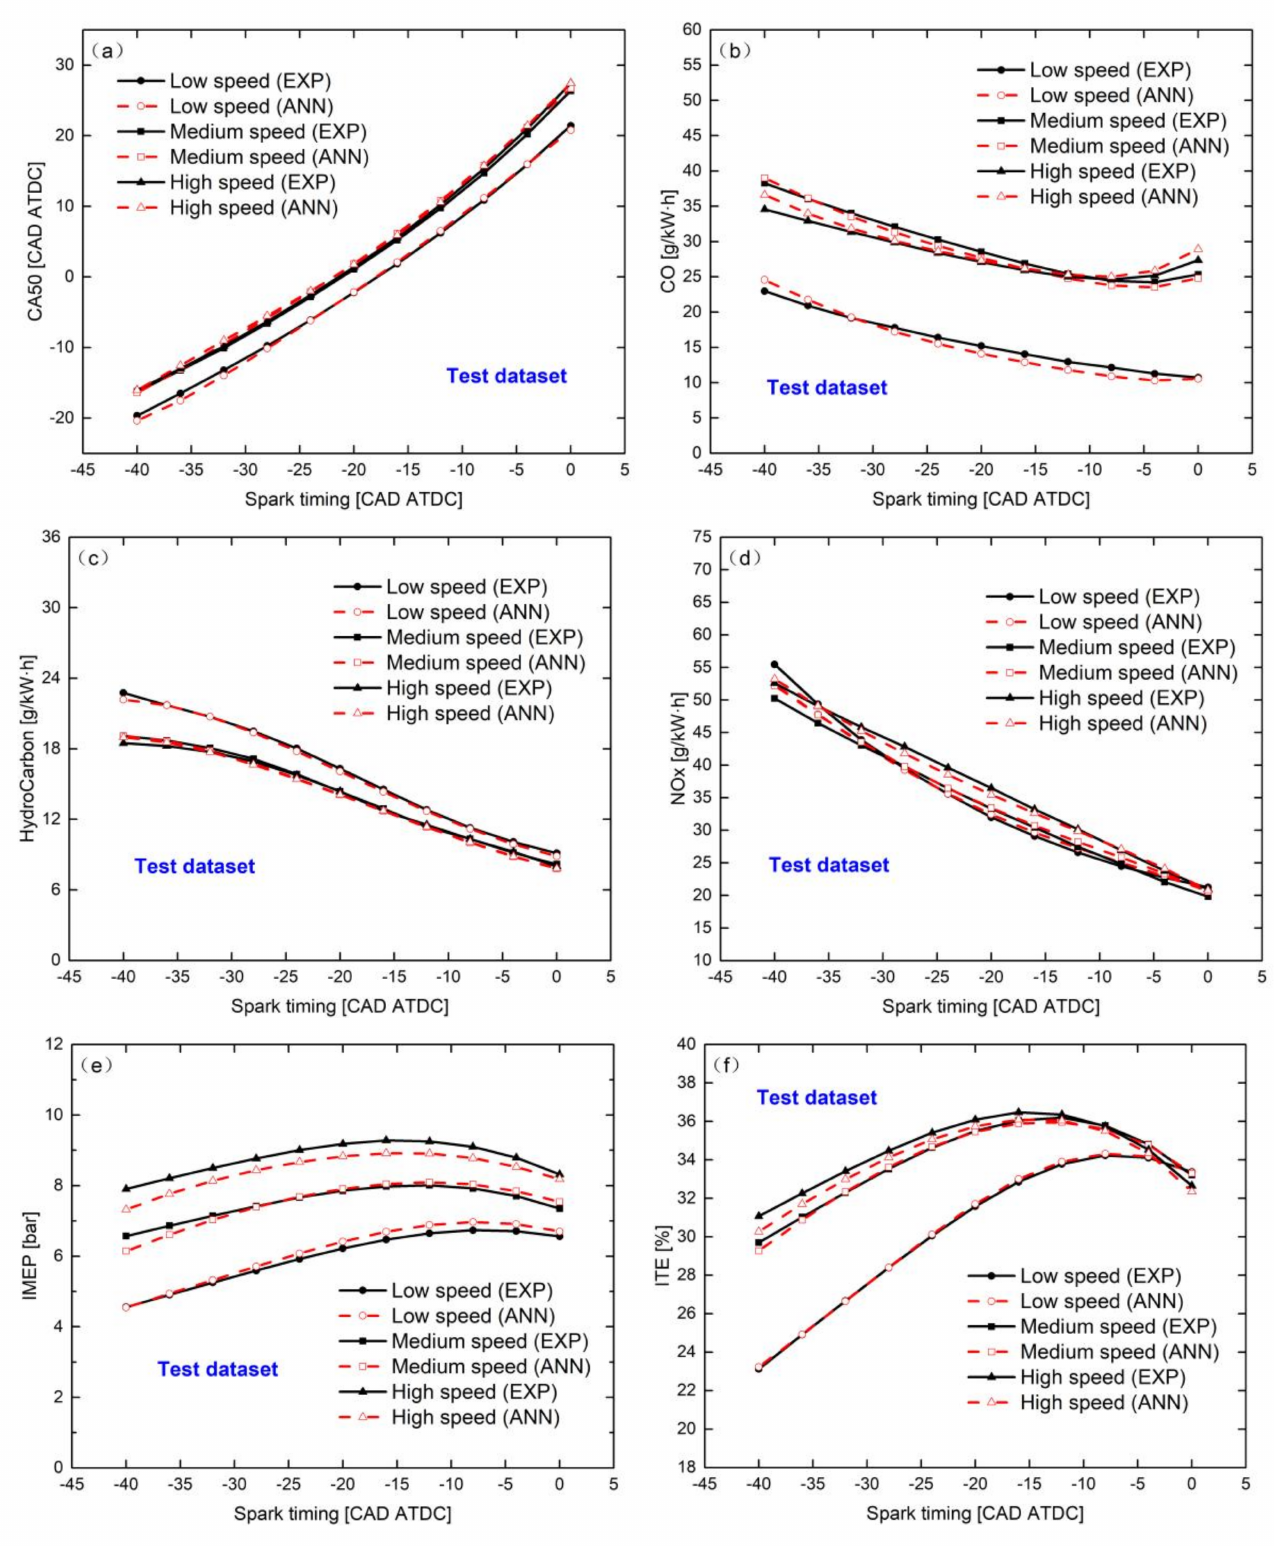
Figure 6. Comparison of ANN model predicted performance and emissions with calibrated data under medium load for the steady test dataset: spark timing effects: ( a ) CA50, ( b ) CO, ( c ) UHC, ( d ) NOx, ( e ) IMEP, ( f )